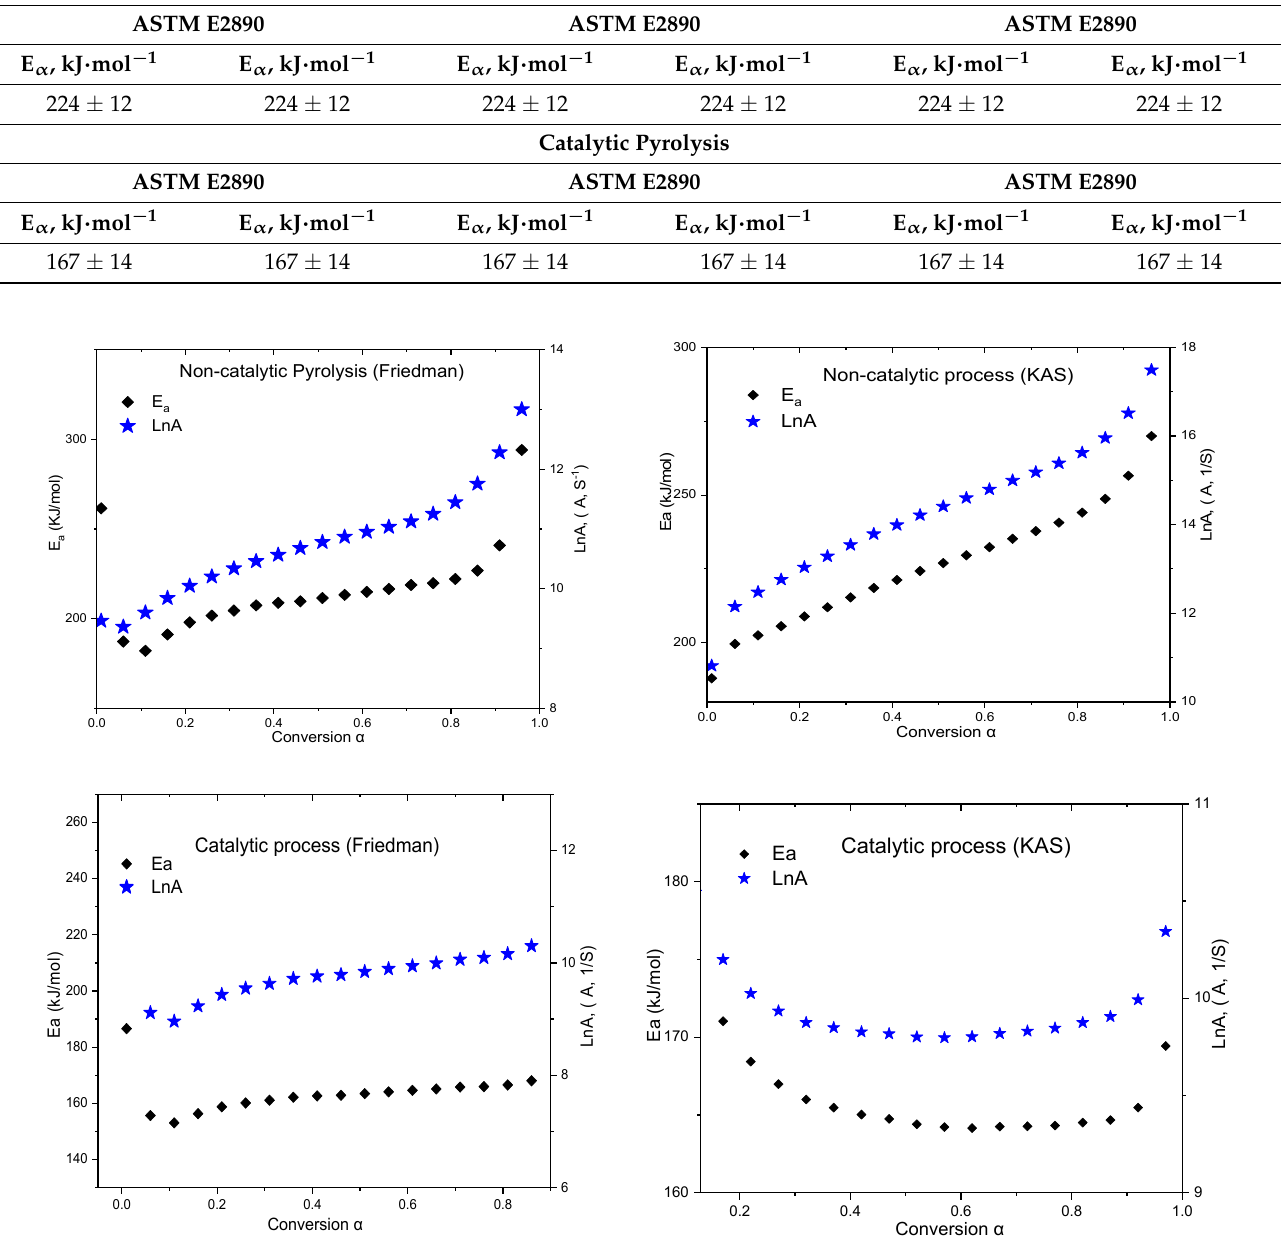
Figure 3. Pyrolysis activation energy dependency on conversion degree in the presence and absence of catalyst obtained by KAS and Friedman.